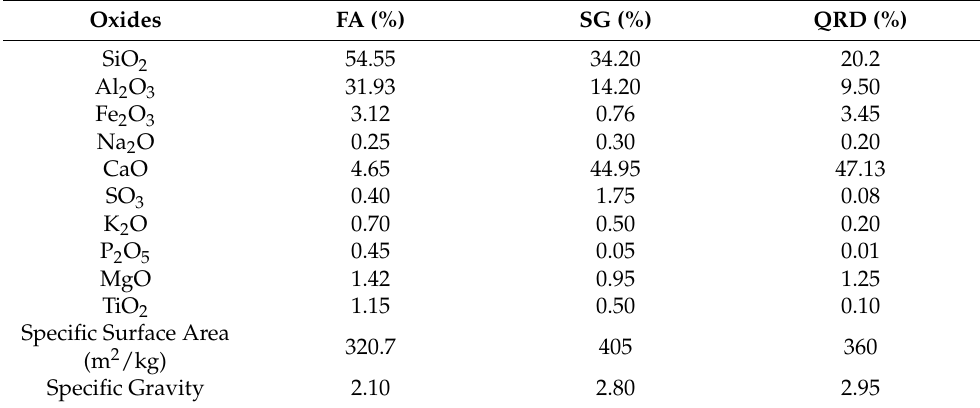
Table 3. The chemical composition from XRF analysis and physical properties of FA, SG, and QRD.